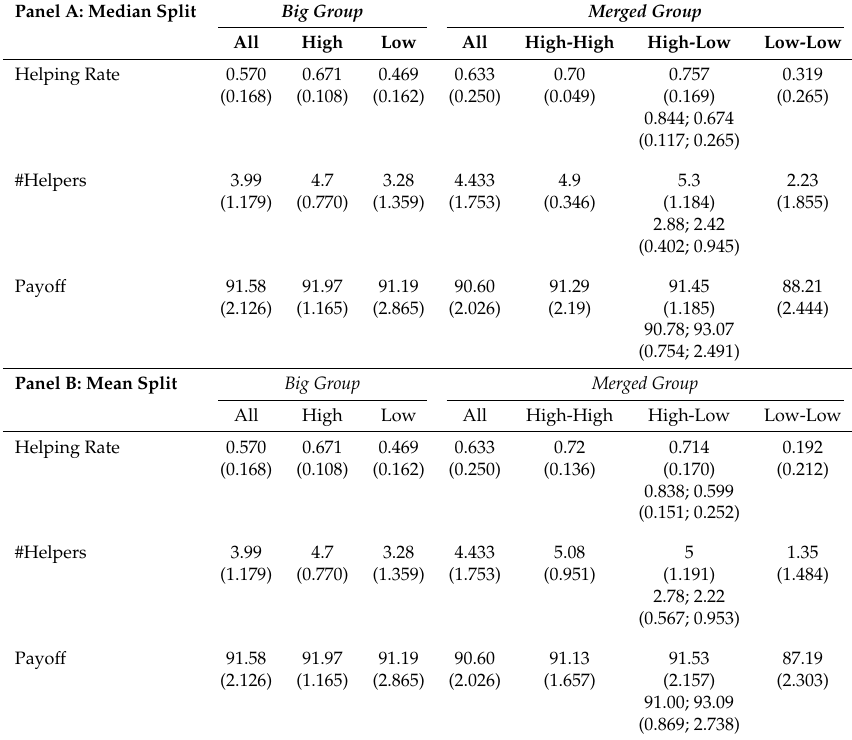
Figure A2. High and low helping norms in Part A by Part B groups. Table A3. Average helping rate and average group payoff in Part B by treatment and sub-group—median split and mean